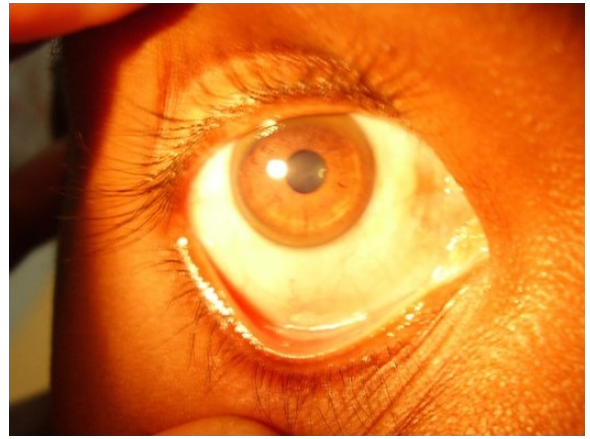
Figure 2: K-F ring in the right